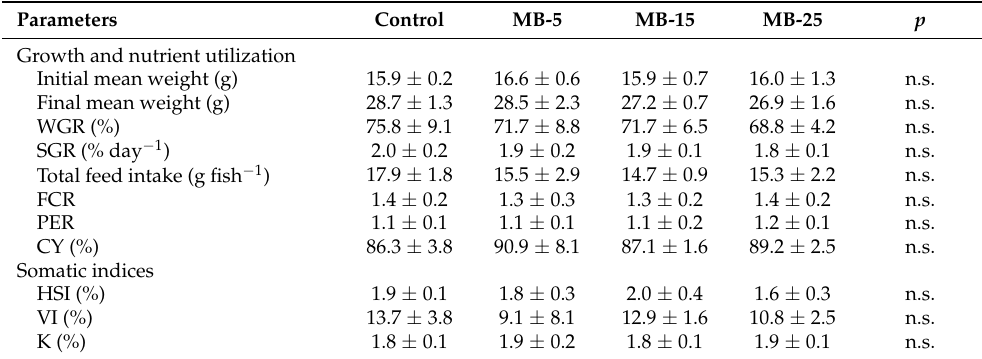
Table 3. Growth performance, nutrient utilization, and somatic indices of juvenile S. aurata fed experimental diets for 30